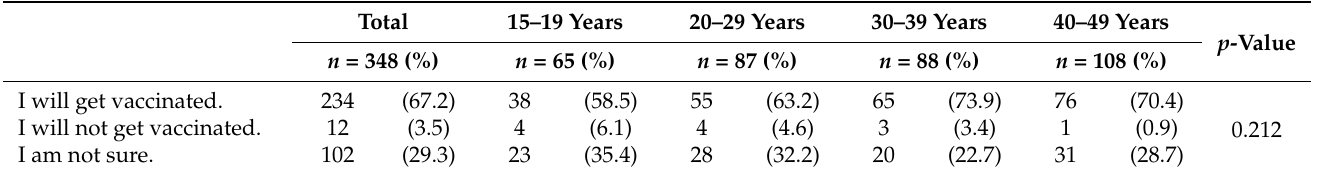
Table 3. Intention regarding the third vaccination among those who answered, “My second vaccina- tion is complete”.